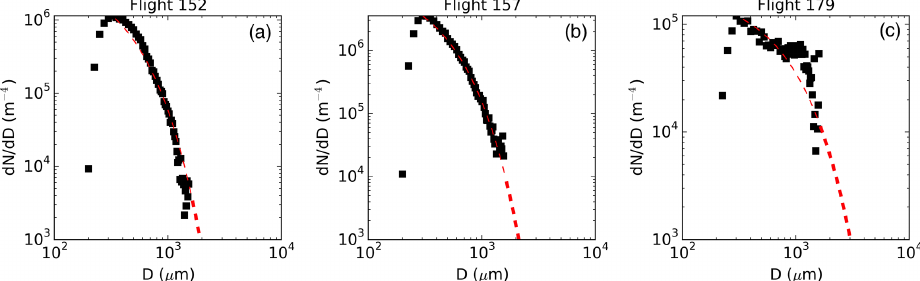
Figure 8. Average size distribution of the crystals identified with the CIP for the flights (a) 152, (b) 157, and (c) 179 (black squares), along with the exponential distribution approximating them (red dashed line). The relative increase in ice mass when further integrating from 1.5mm to larger diameters (equal to the relative error on the actual ice mass used in this study) is about 3% (a) , 2.5% (b) , and 65% (c) (see text for